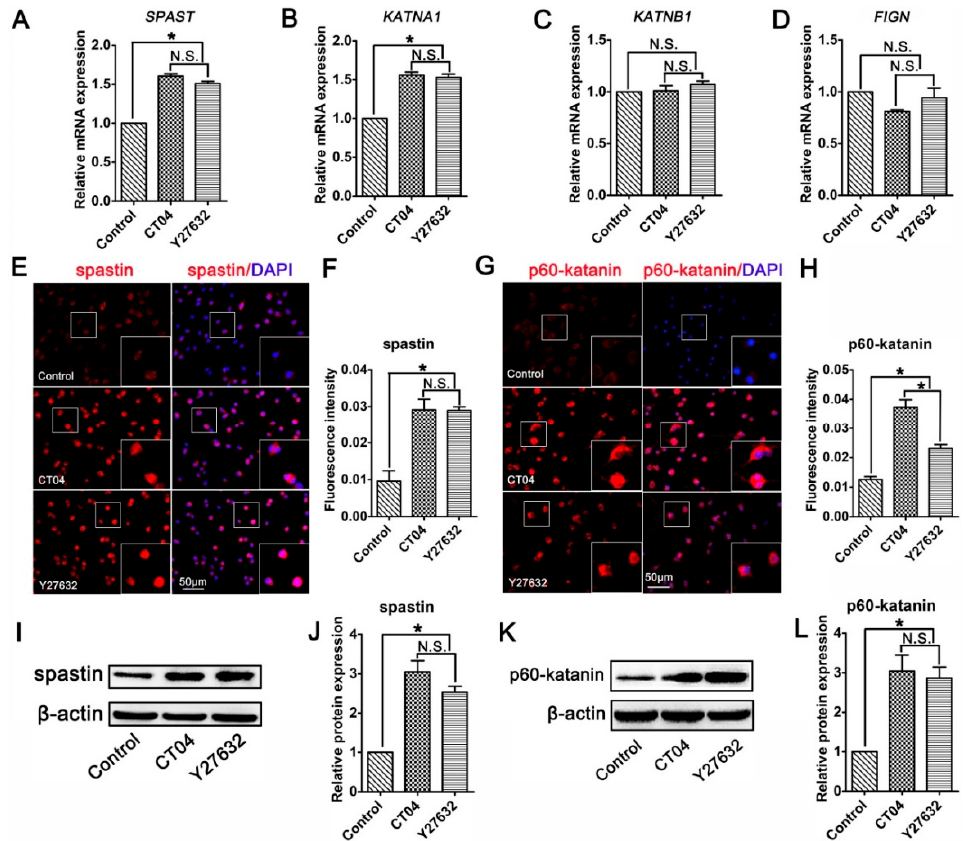
Figure 4. Inhibition of the RhoA signaling pathway upregulates the expression of spastin and p60-katanin in neuronally differentiated PC12 cells. ( A – D ) Quantitative RT-PCR analysis demonstrated that the mRNA levels of SPAST and KATNA1 were increased in the presence of CT04 or Y27632, whereas the mRNA levels of KATNB1 and FIGN were not influenced by CT04 or Y27632. ( E – H ) Immunocytochemistry and quantification revealed that the immunointensities of spastin and p60-katanin were statistically increased in the CT04- or Y27632-treated cells. ( I – L ) A quantitative analysis of Western blots illustrated the different protein levels of spastin and p60-katanin in each group. Both the mRNA and protein levels of the target proteins in the control group were normalized to 1. The data are presented as the mean ± SEM values (*indicates p < 0.05, meaning a statistically significant difference, while N.S. indicates non-significance).